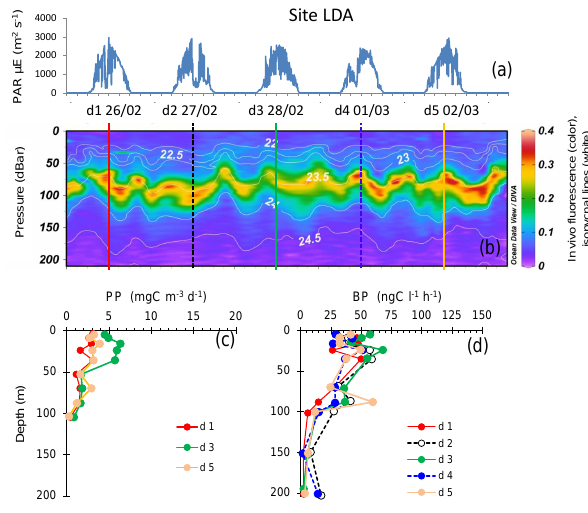
Figure 5. Evolution of surface PAR (a) , in vivo fluorescence and pycnoclines (b) , PP (c) and BP (d) at site LDA. Time units in local time; day 1 was 26 February 2015. BP samples were taken at the 12:00 ctd cast, while samples for PP insitu were taken at the 03:00 ctd casts (days 1, 3 and 5). In graph (b) , in vivo fluorescence is in color, isopycnes (kgm − 3 ) are the white lines and vertical bars show the 12:00 ctd cast sampled for BP each day (1 to 5), with corresponding colors used for plotting BP vertical profiles in (d)